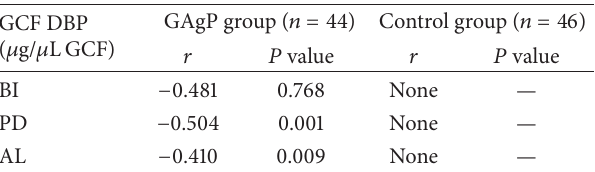
Table 3: Partial correlations between GCF DBP concentrations and clinical parameters after adjusting for age, gender, smoking status, and BMI